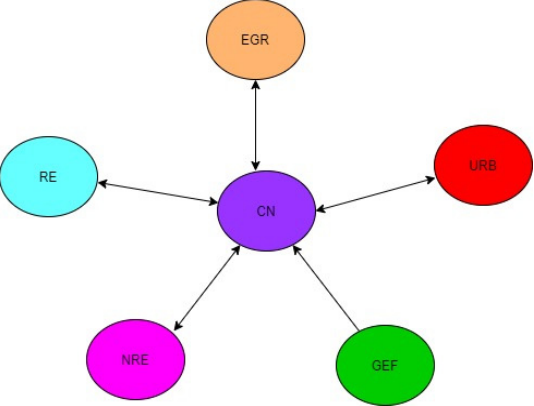
Figure 2. Causalities for all the 16 MENA Countries selected for the Study.